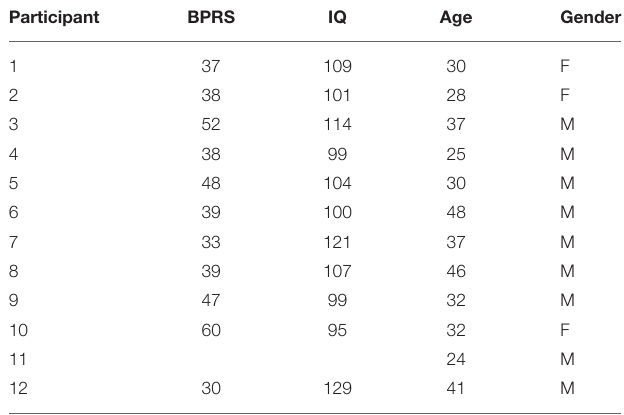
TABLE 1 | Summary demographic information and MATRICS scores for the schizophrenia, autism, and control groups.